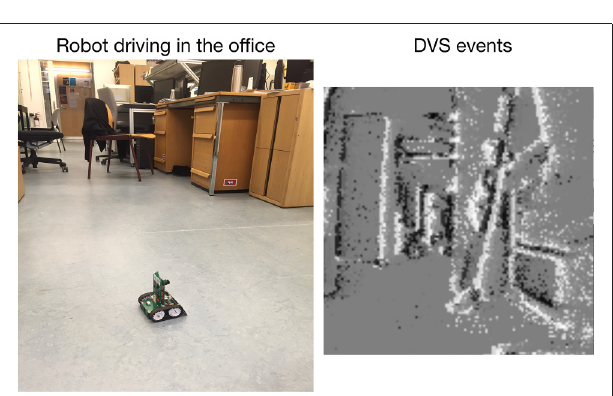
FIGURE 3 | The Pushbot robot driving in the office (left) and a visualization of the DVS output (right) , accumulated over